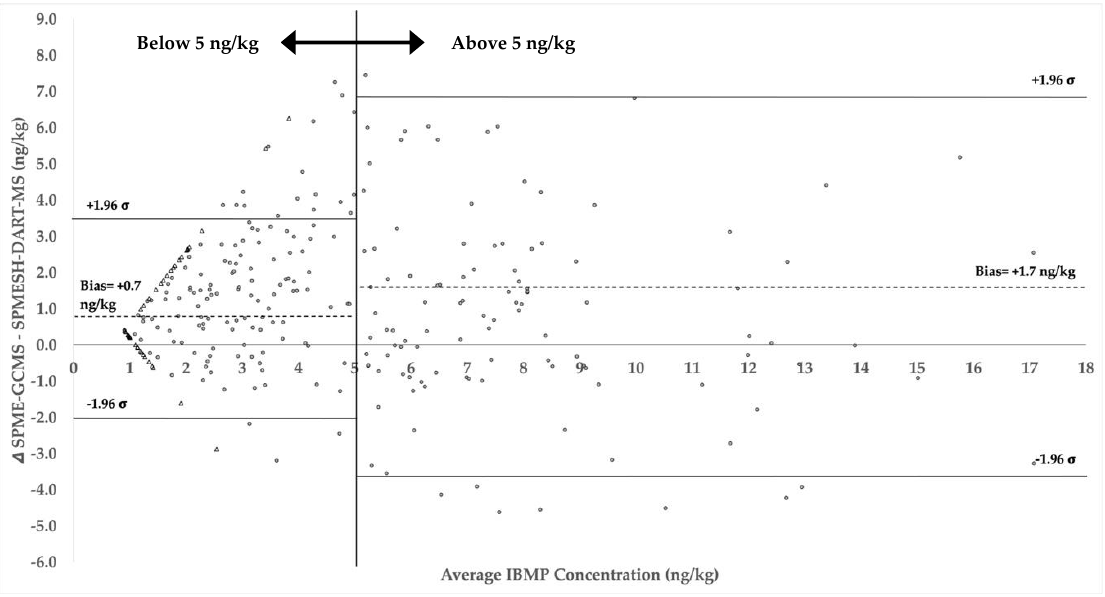
Figure 5. Bland–Altman agreement analysis for native IBMP measured in Merlot and Cabernet Sauvignon grapes harvested at commercial maturity in 2021 ( n = 302). Bias (dotted lines) and up- per/lower limits of agreement (solid lines) are shown represent average concentrations above and below 5 ng/kg. Samples for which IBMP was undetectable by one or both methods are shown as hollow triangles, and samples for which IBMP was detectable using both methods are shown as closed circles .